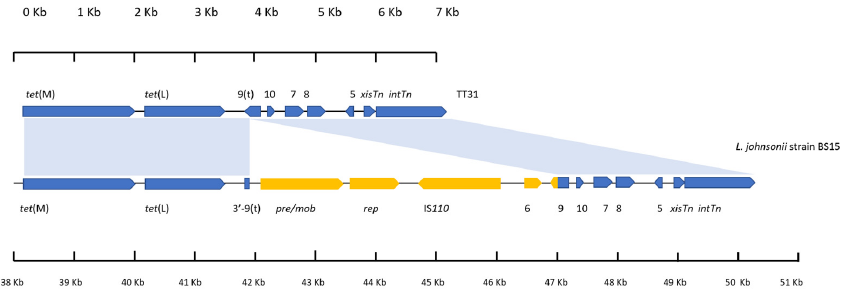
Figure 2. An alignment of the left 7226 bp of TT31 and a 12,313 bp region of the L. johnsonii strain BS15 genome. Blue shaded areas represent areas of alignment between the two sequences. Individual scales accompany each gene schematic. tet( M) and tet (L) are encoded by both as are orf10, orf7, orf8, orf5 , xisTn and intTn . orf9t is encoded by TT31. An insertion is present in the orf9t of L. johnsonii strain BS15 relative to TT31. pre/mob , rep , IS 110 transposase and orf6 genes are present on this insert; highlighted in yellow. Also present on this insert is the 183 bp 3 ′ —end of the full length orf9 (highlighted in yellow) in frame with the start codon of the 5 ′ end of orf9 that is found in all the sequences (highlighted in blue); thus the full length orf9 is encoded by L. johnsonii strain BS15. The L. johnsonii genome still maintains the 3 ′ —end of orf9t (highlighted blue). 3.5. tet(L) and the 3 ′ -orf9t Sequence are Present in the TT31 Tn916-Like Element and Tn6079 Tn 6079 (accession: GU951538) is a CTn encoded by Streptococcus gallolyticus that was first identified from a functional metagenomic screen of the infant gut [10]. As Tn 6079 encoded tet (L) and had a similar genetic organisation to TT31, the left 7226 bp of TT31 was aligned with the 11,701 bp accessory, regulation and recombination modules of Tn 6079 . This revealed a 99% nucleotide identity (82% cover) between the two sequences (Figure 3). Alignment of TT31 (between 1 bp and 3758 bp) and Tn 6079 (between 17,176 bp and 20,917 bp) represents homology between the tet (M) and tet (L) encoding sections of the sequences. It also confirms that the 99 bp 3 ′ -end of orf9t is present on Tn 6079 . The orf5 , xisTn and intTn encoding regions of TT31 (between 4993 bp and 7226 bp) and Tn 6079 (between 26,639 bp and 28,876 bp) also aligned (97% nucleotide identity) (Figure 3). The orf8 , orf7 , orf10 and the 5 ′ —end of orf9t encoding region of TT31 (3759 bp–4993 bp) did not align with Tn 6079 . Additionally, the accessory Tn 6079 genes encoding a plasmid recombination protein ( pre/mob ), a plasmid replication protein ( rep ) and erm (T) that is flanked by IS 1216 sequences (20,918 bp–26,639 bp) did not align with TT31, (Figure 3). The pre/mob and rep genes of Tn 6079 had >99% nucleotide identity to those identified in the L. johnsonii strain BS15 genome insertion. Figure 3. An alignment between the left 7226 bp of TT31 and the right 11,701 bp of Tn 6079 . Regions of Tn 6079 and TT31 that aligned are indicated by the blue shaded areas. Individual scales accompany each gene schematic. tet (M) and tet (L) are present in both as are orf5 , xisTn and intTn . orf9, orf10, orf7 and orf8 are not present on Tn 6079 . The pre / mob , rep and erm (T) genes (the latter of which is flanked by IS 1216 sequences) that are encoded by Tn 6079 are not present on TT31 and are highlighted in yellow. The region of Tn 6079 highlighted by blue brackets is present in the L. johnsonii BS15 genome also.